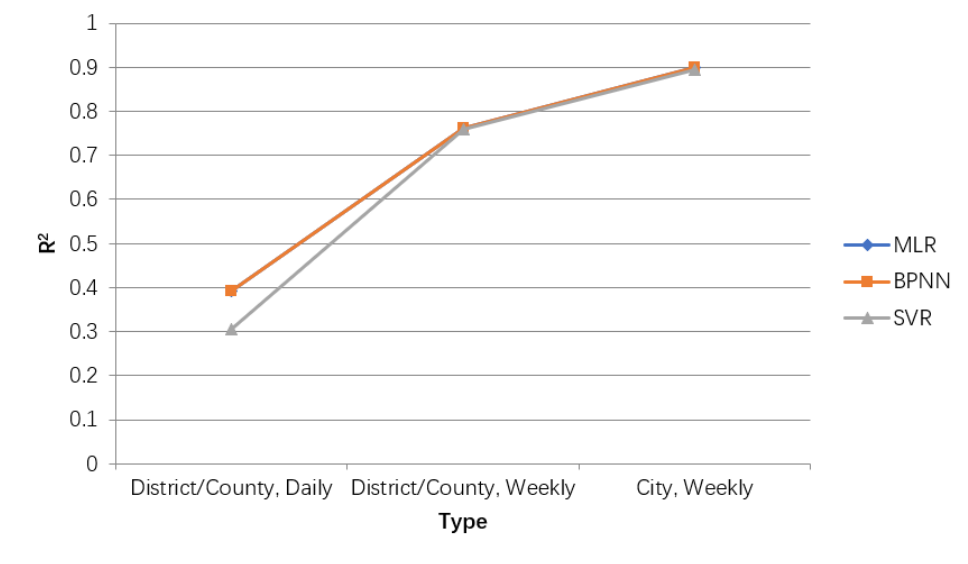
Figure 11. Comparison line chart of results of different prediction accuracy. The value represents results for R2, MAE/10, AWE for different parameters settings.